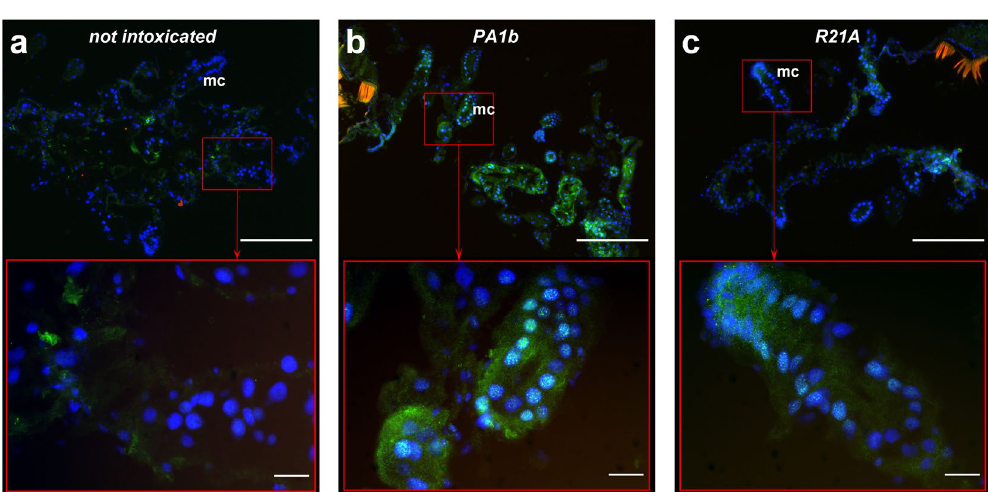
Figure 6. Immuno-localization of the caspase-3 active form in sensitive S. oryzae (strain WAA42) intoxicated by PA1b. Midguts of the sensitive weevil WAA42 were dissected, embedded, frozen and then tissue sections (7 µ m) were cut. Slides were prepared as described in the Experimental Procedures section. Caspase-3 was labelled with rabbit anti-cleaved caspase-3 and revealed using a secondary antibody Alexa fluor 488 donkey anti-rabbit IgG. DAPI was added for nuclear staining. ( a ) Control (no PA1b); ( b ) weevils intoxicated with PA1b, at 400 µ g per g of food, for 4 days; ( c ) weevils intoxicated with the inactive mutant of PA1b, R21A, at 400 µ g per g of food, for 4 days. Upper panel scale bar = 200 µ m; lower panel scale bar = 20 µ m. Blue: nuclei stained with DAPI; green: caspase 3; brownish-red: non-specific signal from background autofluorescence. mc: mesenteric